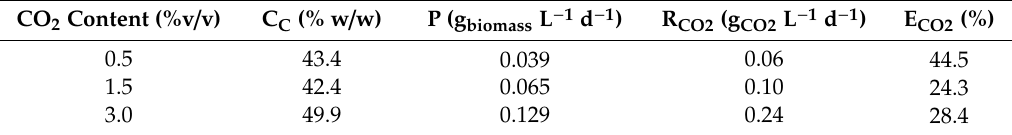
Table 1. Carbon elemental, average CO 2 capture rate, and CO 2 capture e ffi ciency.